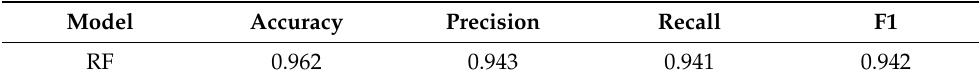
Table 7. Classifier results for RF with downsampling to 25